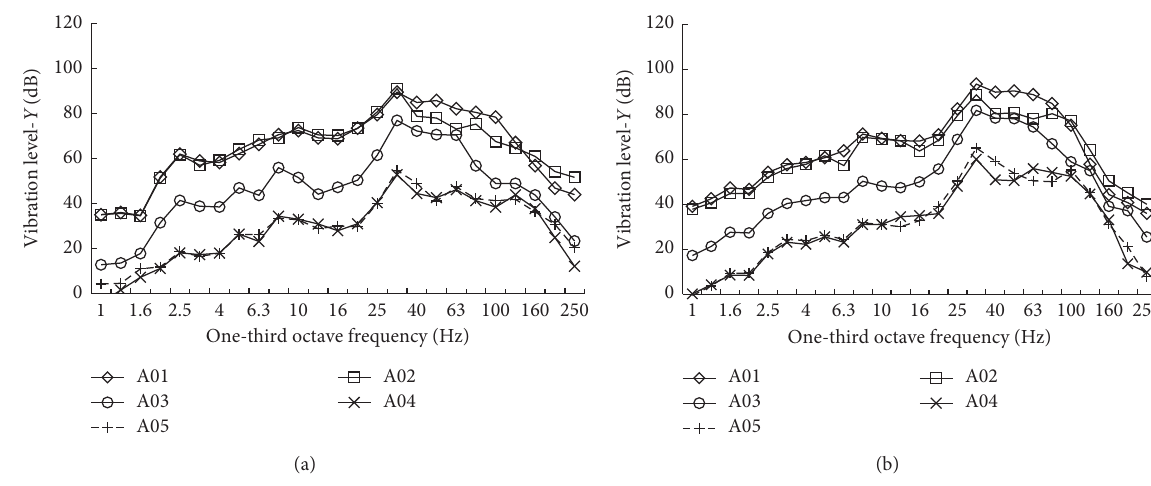
Figure 18: Vibration levels of ground surface points: (a) Z direction; (b) Y